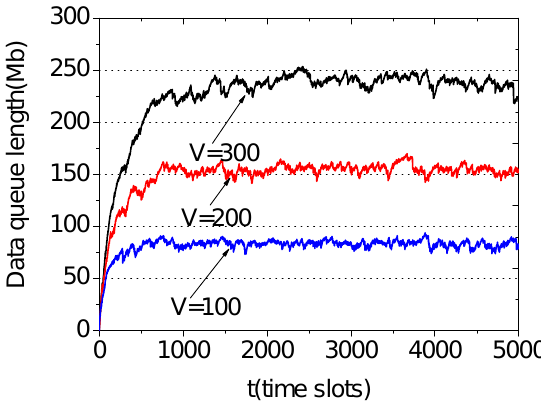
Figure 3. Data queue dynamics.